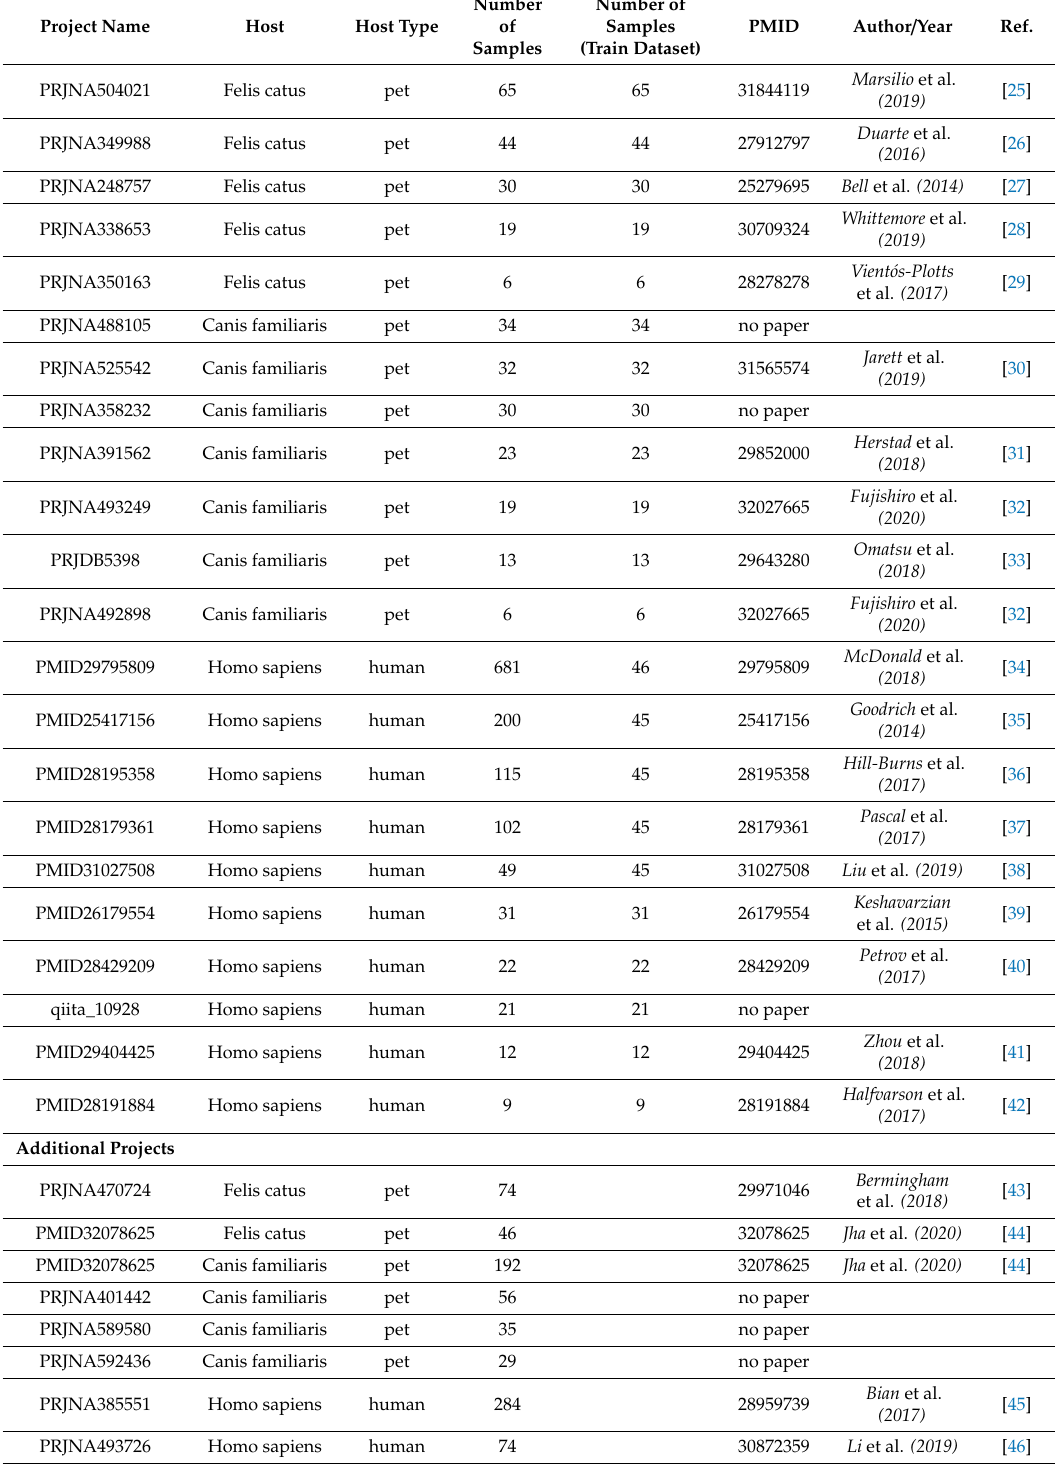
Table 1. Data used in the